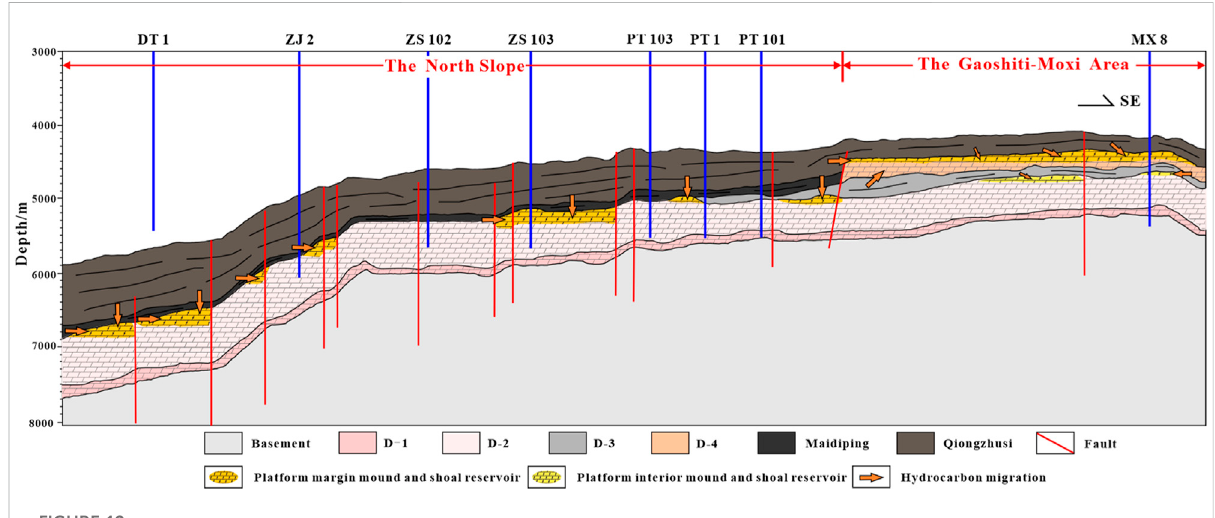
FIGURE 12 The hydrocarbon accumulation mode of the Sinian Dengying gas reservoirs in Central Sichuan